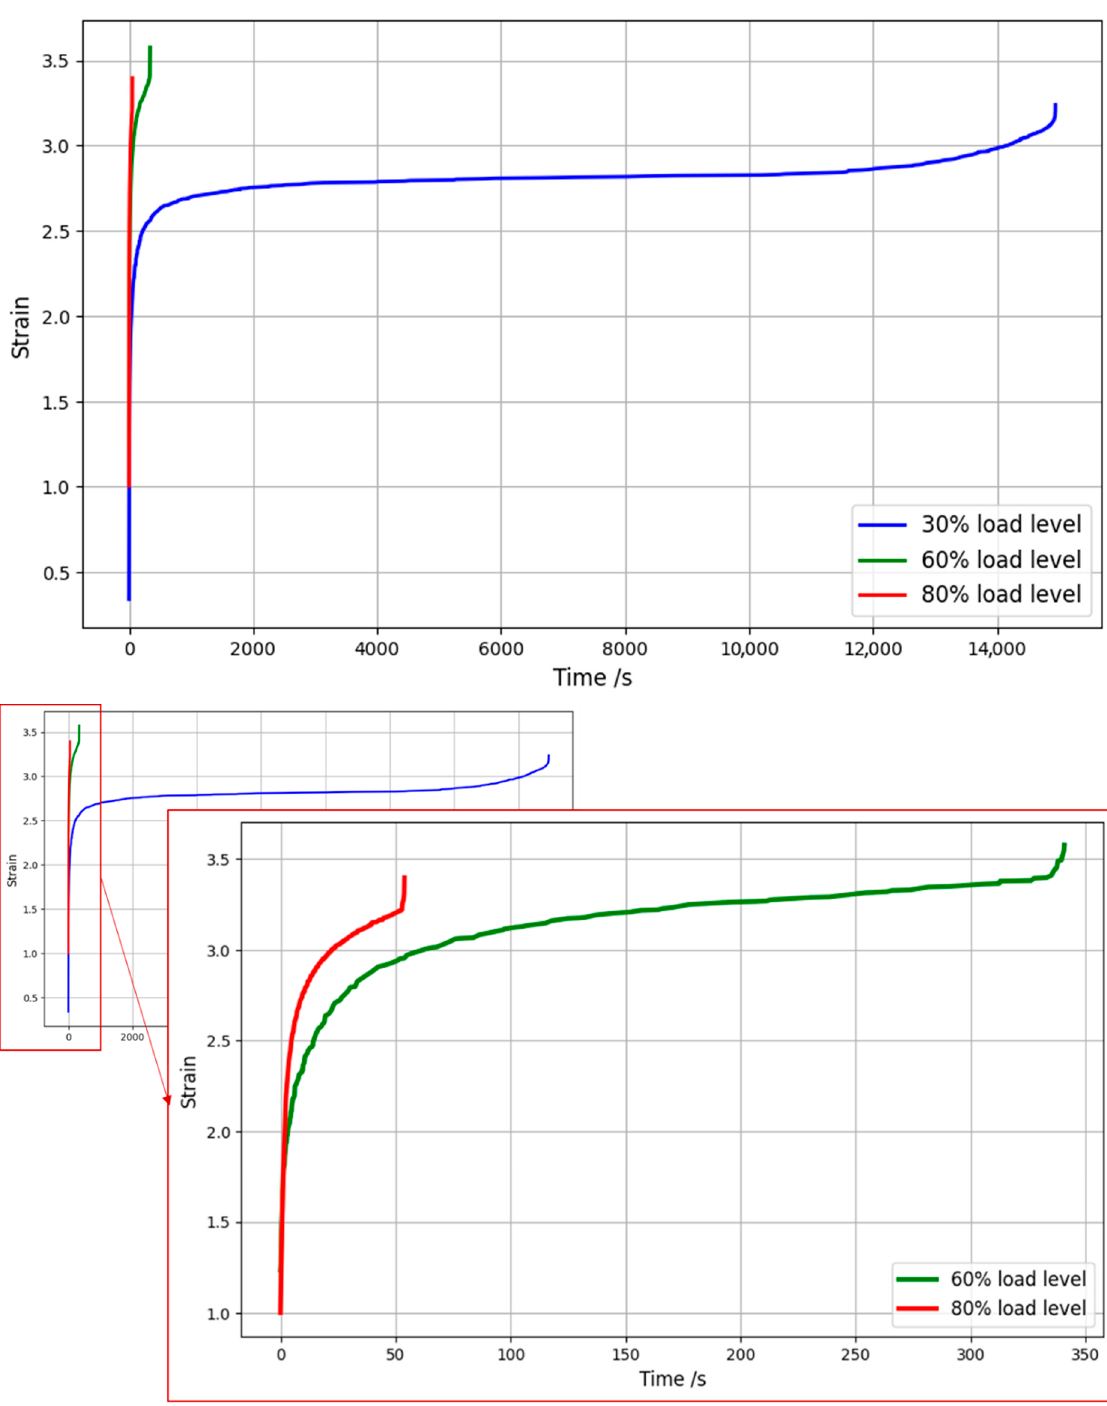
Figure 10. Experimental static creep representative curves for 30%, 60%, and 80% load level: three levels ( top ) and higher levels in detail ( bottom ).